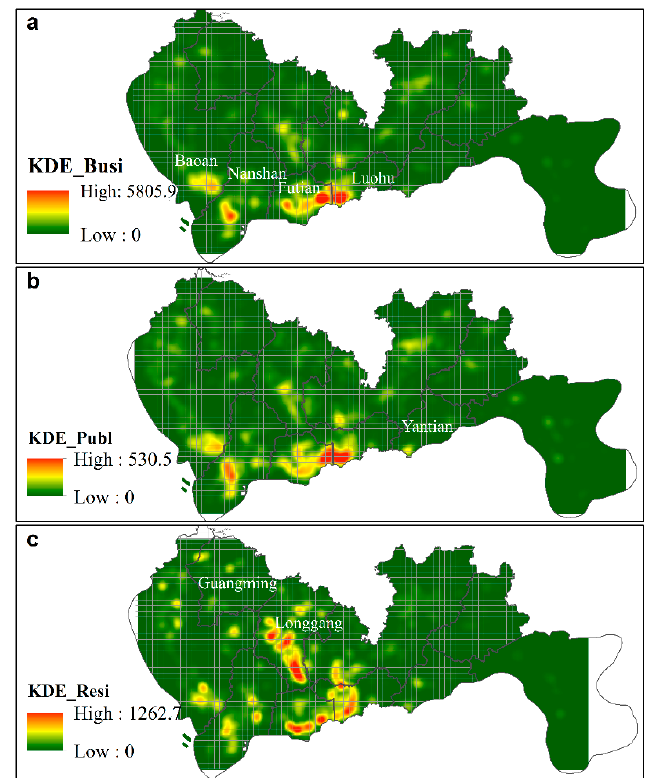
Figure 7. Spatial distributions of intensities of commercial and business facilities ( a ), public and administrative services ( b ), and residential sites ( c ). These represent commercial land use intensities, public service land use intensities, and residential land use intensities, respectively.